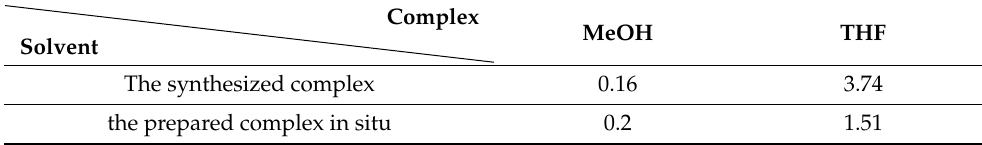
Table 3. Oxidation rate of [(Cl) 2 Mn(RCOOET)] catalyzed oxidation of catechol ( µ mol.L − 1 .min − 1 ). Complex